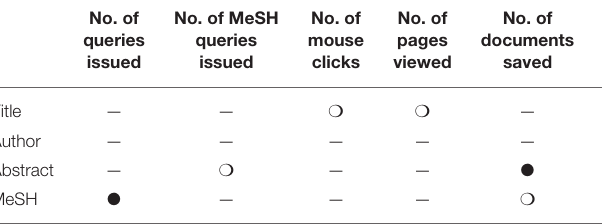
TABLE 8 | Summary of the relationship between search behavior and gaze